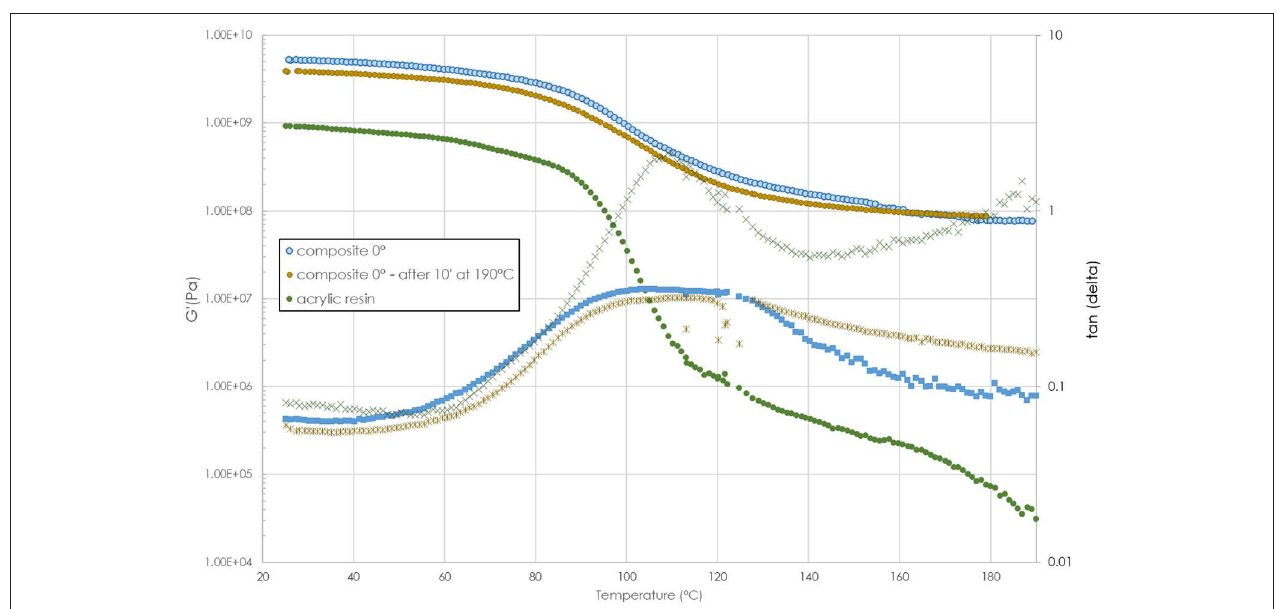
FIGURE 8 | Dynamic shear storage modulus (G ′ ) and tan(delta) measured by DMA of pure resin ELIUM C595 E (green dots) and pultruded profile with ELIUM C595 E in 0 ◦ glass fiber direction (blue dots) and 0 ◦ glass fiber direction after a post-treatment simulating the thermoforming process at 190 ◦ C for 10min (blue dots).